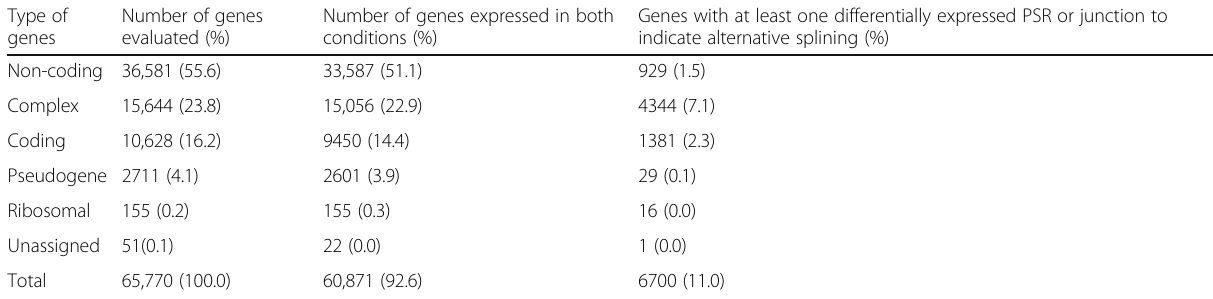
Table 2 Summary of alternative splicing analysis in RPE samples in two different conditions ( Prpf31 A216P/+ vs WT mice). Default filter criteria, splicing index < − 2 or > 2 and ANOVA p -value <